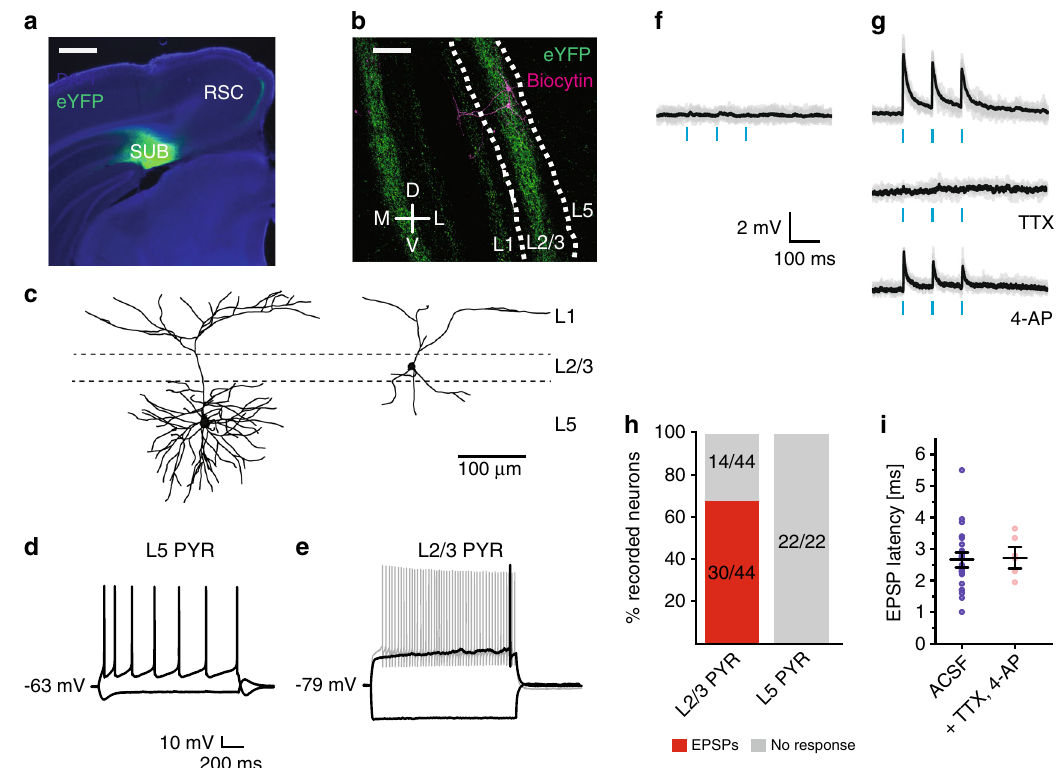
Fig. 7 Connectivity between subicular VGlut2 + bursting cells and the gRSC, characterized in vitro. a Infection of VGlut2 + subicular cells with AAV- FLEX-ChR2-YFP in VGlut2-Cre mice reveals strong projections onto super fi cial layers of the gRSC (green, eYFP; blue, DAPI). Scale bar, 500 µ m. b Magni fi ed image showing the (bilateral) restriction of subicular VGlut2 + terminals predominantly to L2/3 (green), as well as two biocytin-labeled L2/3 pyramids (magenta). White lines, L2/3. Scale bar, 100 µ m. c Reconstructed representative examples of deep (left) and super fi cial (right) gRSC pyramids. Super fi cial cell is the one shown in ( b ). d Membrane potential responses of a deep gRSC pyramid to injection of ±80 pA. e Responses of a super fi cial cell to current injection of ±80 pA (black) and 160 pA (gray). f Example traces of responses to light stimulation of a deep gRSC pyramid in ACSF. g Example responses of a L2/3 gRSC pyramidal cell in ASCF (top), after adding 10 µ M TTX (middle) and after the addition of 4-AP (bottom). h Summary of responses of gRSC pyramids to subicular VGlut2 + fi ber light stimulation. i) EPSP latencies (mean ± s.e.m) of all responsive super fi cial cells ( n = 30) and a subset where TTX and 4-AP were applied ( n = 6), indicating monosynaptic